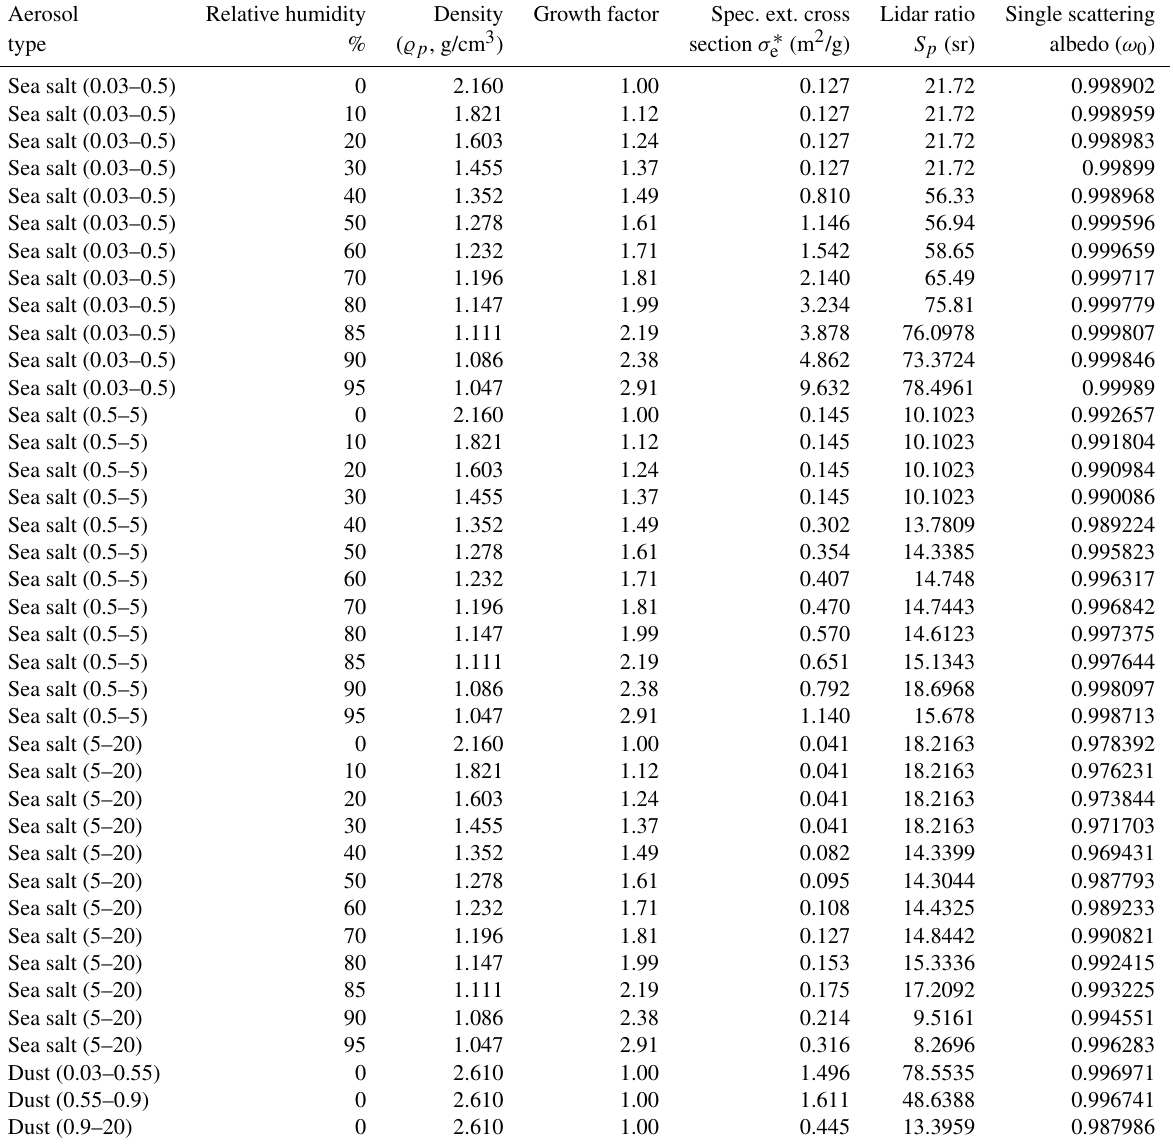
Table C1. Microphysical properties of aerosols assumed for conversion of model mass mixing ratios to β ∗ (z) at 1064nm. Aerosol Relative